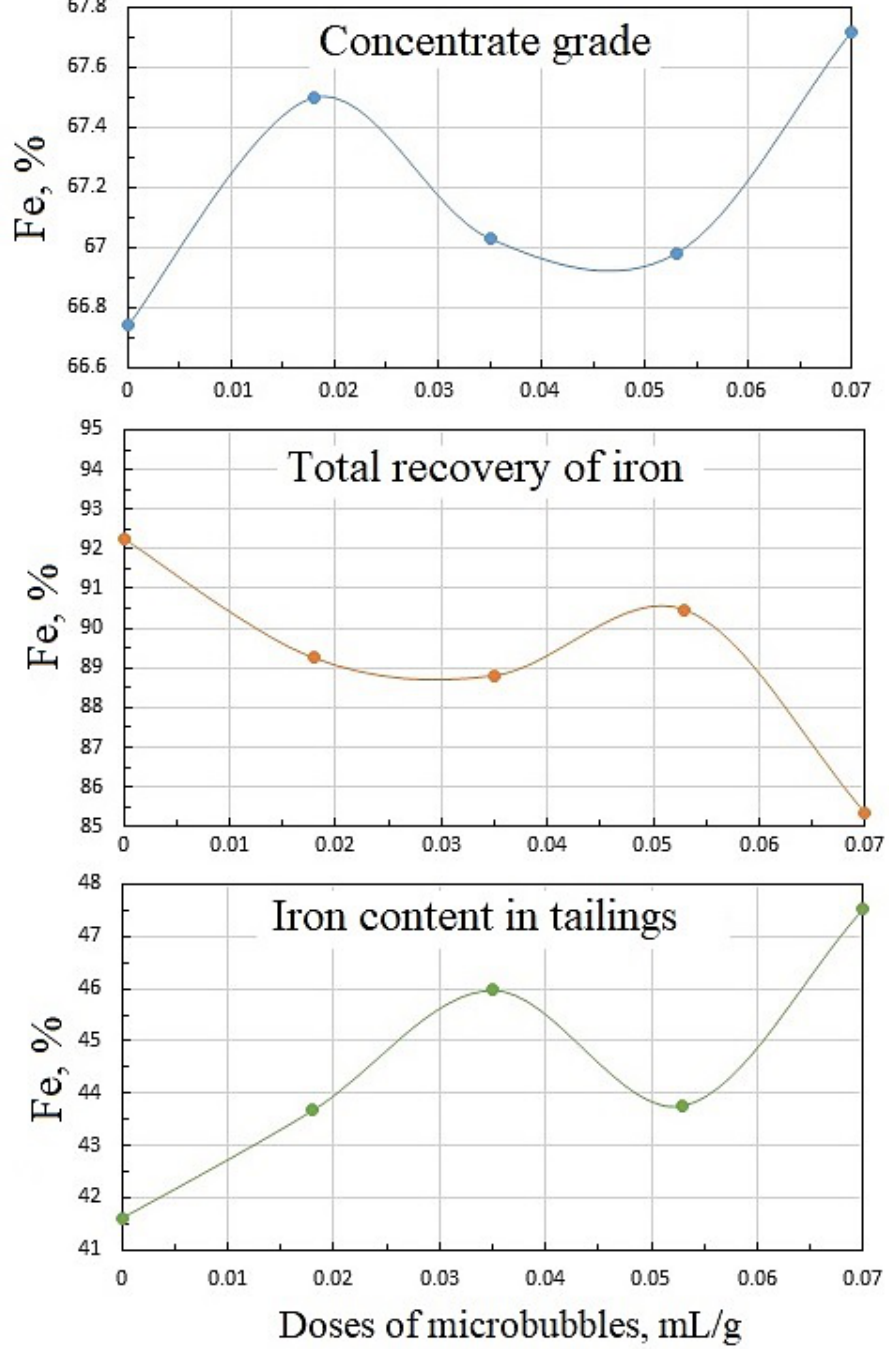
Figure 10. Dependencies of concentrate grade, iron recovery, and iron content in tailings on microbubble doses supplied before flotation start: collector dose, 20 g / t; airflow rate, 0.18 L /